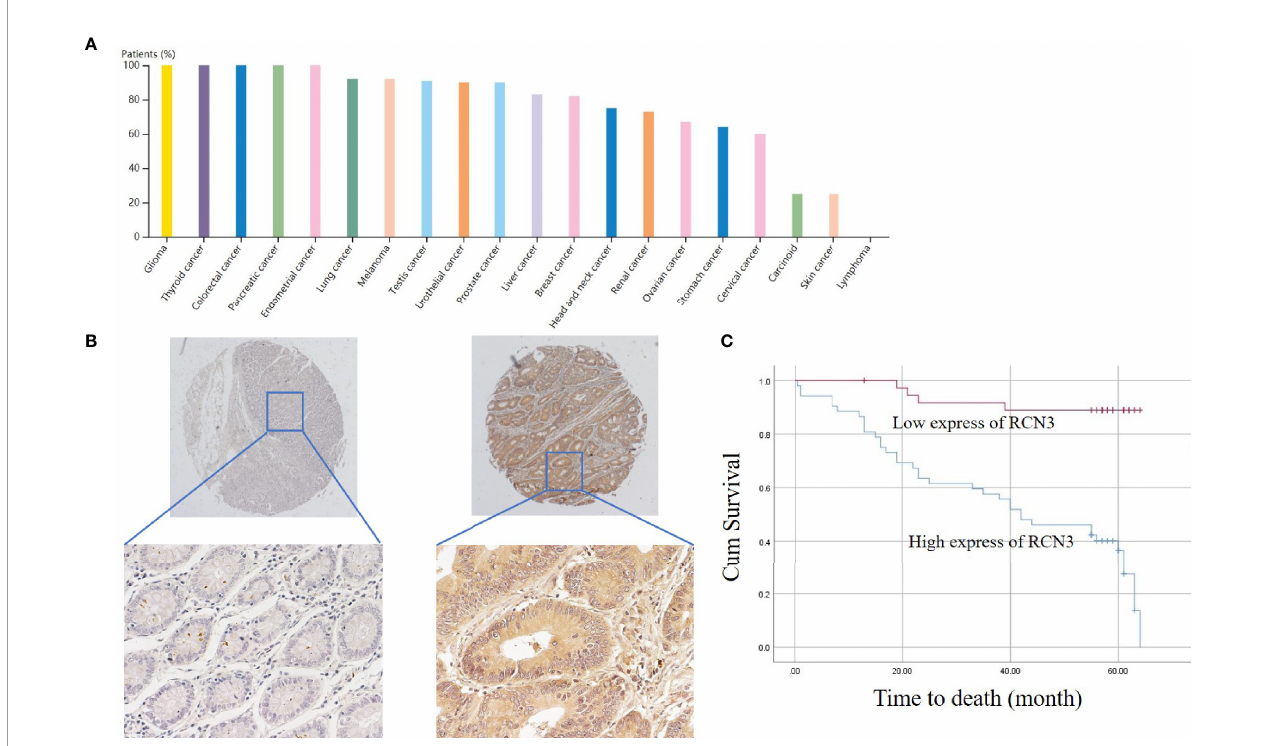
FIGURE 5 | Protein expression of RCN3 in pan-cancer and its prognosis role in CRC. (A) Protein expression of RCN3 in pan-cancer was shown by the human protein atlas. (B) The protein level of RCN3 was found highly expressed in the TMA containing 89 colon cancer cases. (C) Kaplan – Meier overall survival curves for patients with CRC strati fi ed by low (n = 37) and high (n = 52) expression of RCN3 (P = 0.000).